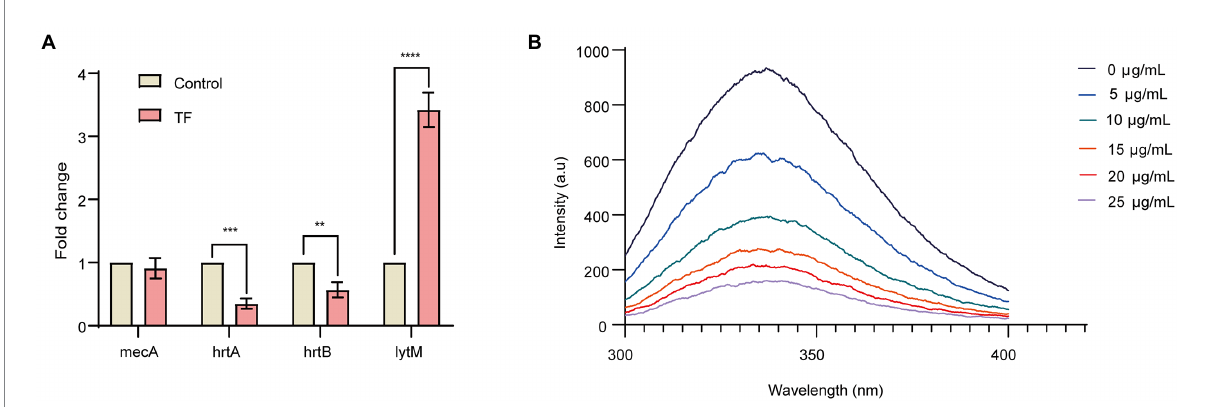
FIGURE 3 Relative expression analysis of candidate genes by qRT–PCR and binding of TF to PBP2a allosteric site. (A) Relative expression analysis of candidate genes by qRT–PCR. The RQ values on the Y-axis show fold-changes in mRNA expression relative to the control group. All values shown here are averages (±standard deviation) from three independent samples. The two-tailed Student’s t test was used for comparisons between groups. ** p < 0.01, *** p < 0.001, **** p < 0.0001. (B) Emission scans of PBP2a intrinsic fluorescence with excitation at 280 nm. TF was titrated into give the final concentrations shown.